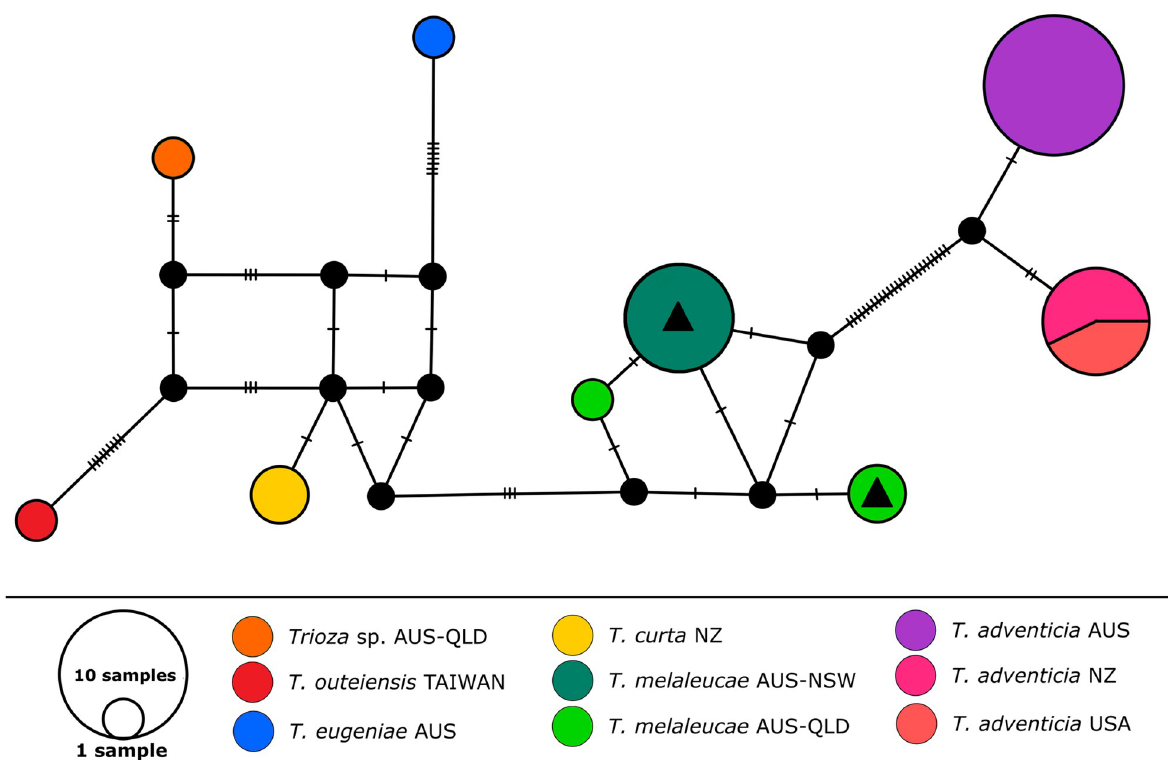
Fig 9. Haplotype network analysis of the samples included in this study, obtained using 33 partial COI DNA sequences. The Queensland (light green) and the New South Wales (dark green) populations of Trioza melaleucae are compared to populations of T . adventicia from New Zealand (fuchsia), USA (pink) and Australia (purple); T . eugeniae from Australia (blue), T . curta from New Zealand (yellow), T . outeiensis from Taiwan (red) and a Trioza sp. from Queensland (orange). Each mutation is represented by a hatch mark while the size of the circles corresponds to the number of sequences included. Black triangles represent the sequences generated in this